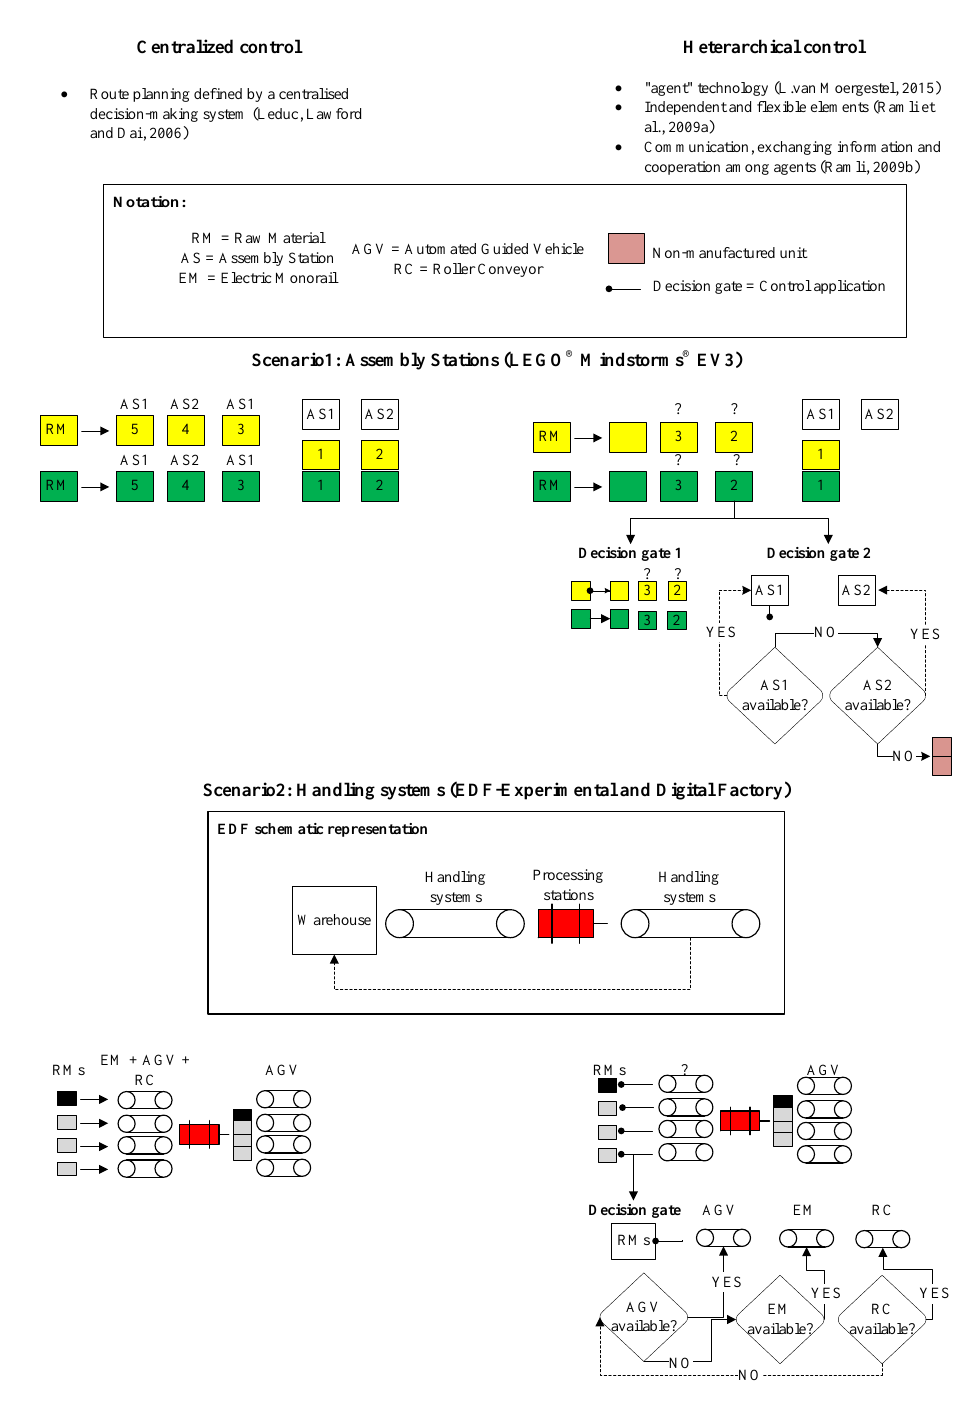
Figure 1. Conceptual framework .